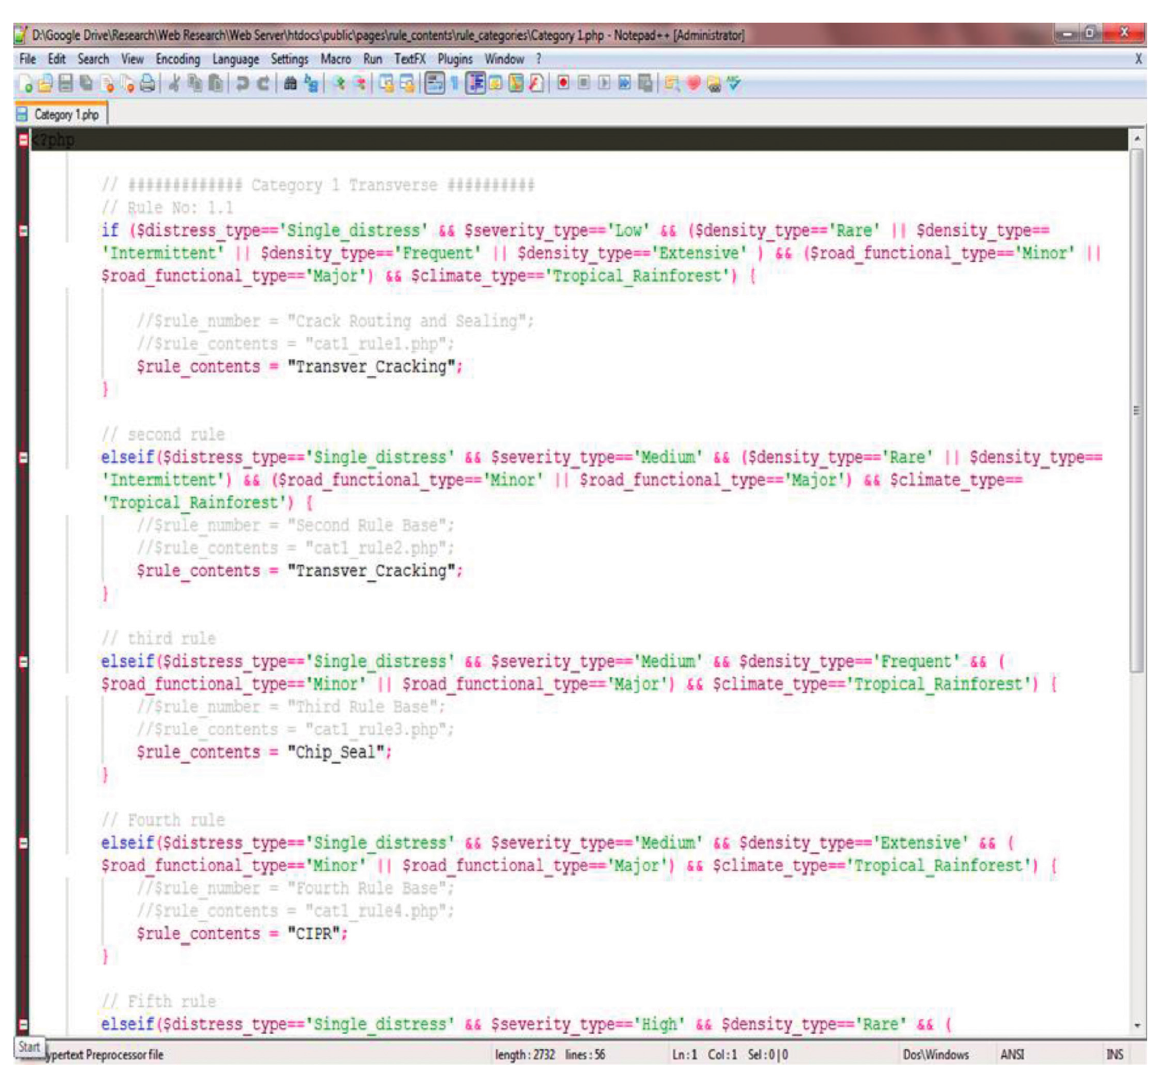
Figure 4: Example of the ESTAMPSYS code